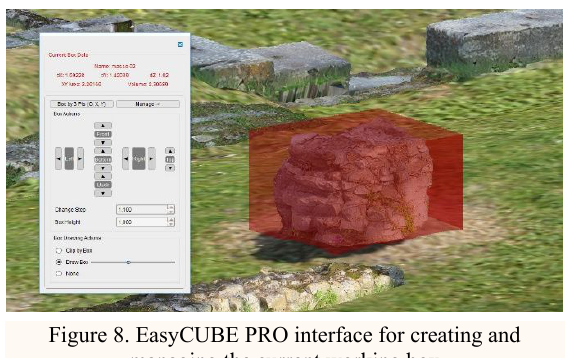
Figure 8. EasyCUBE PRO interface for creating and managing the current working